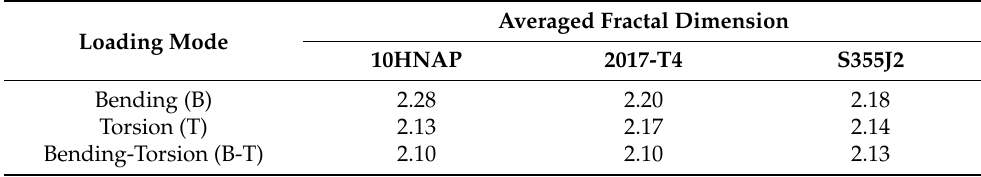
Table 3. Averaged fractal dimension for bending (B), torsion (T) and bending-torsion